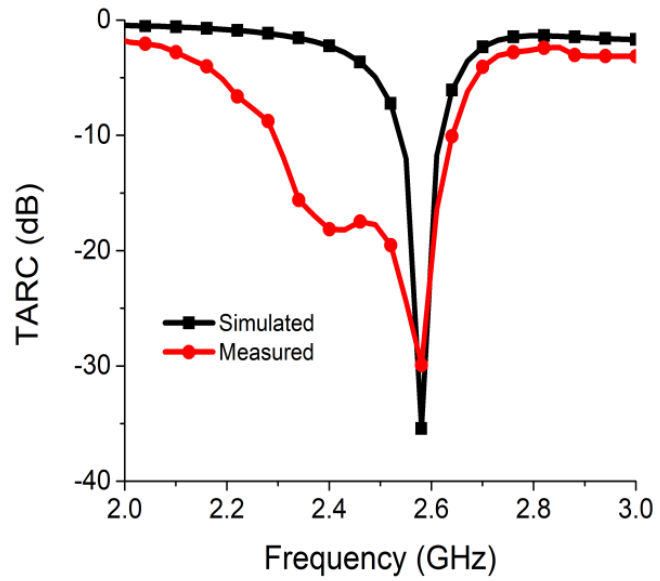
Figure 19. TARC of proposed two-port MIMO antenna.